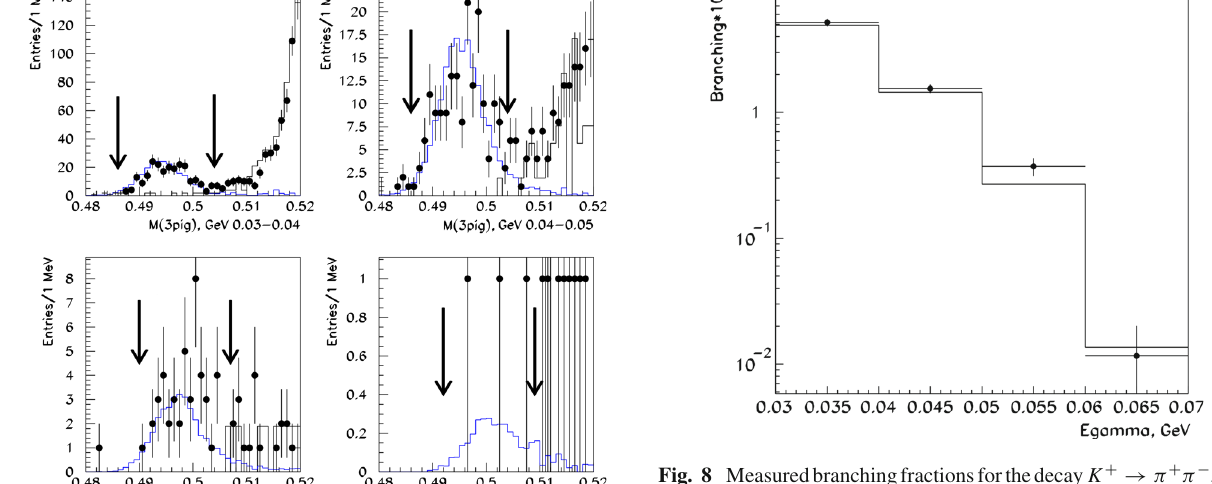
Fig. 8 Measuredbranchingfractionsforthedecay K + → π + π − π + γ in the photon energy ranges in the kaon rest frame for the data (black circles) and the CHPT prediction from [8] (histogram)